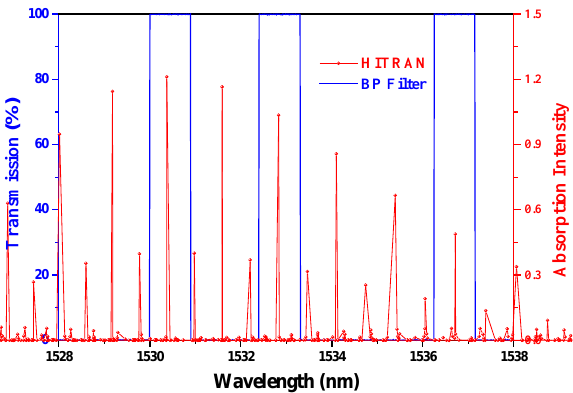
Figure 6. Relationship between the BP filter and the absorption peaks of C 2 H 2 .